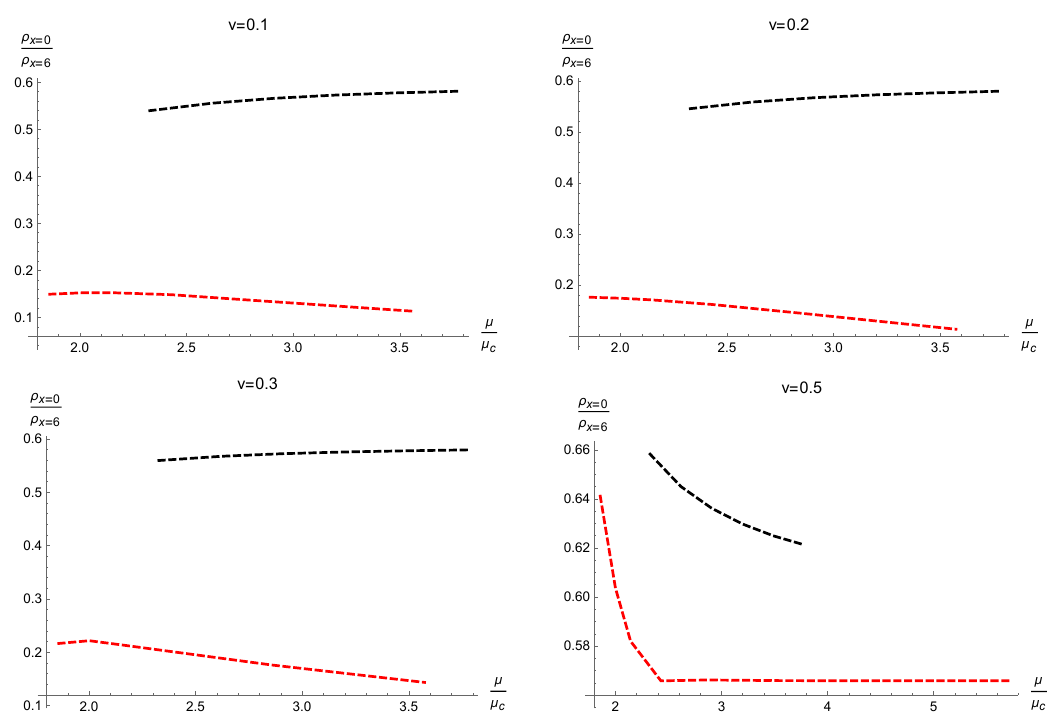
at di(cid:11)erent speeds ( v = 0 : 1 ; 0 : 2 ; 0 : 3 ; 0 : 5) with (cid:26) homo